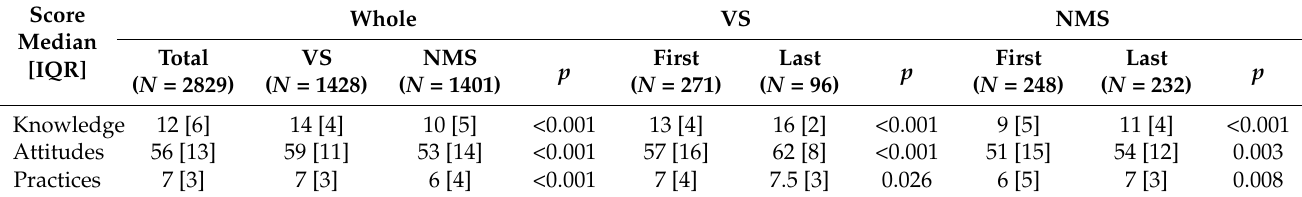
Table 2. Knowledge (K), attitudes (A) and practices (P) scores in veterinary and non-medical undergraduate students.